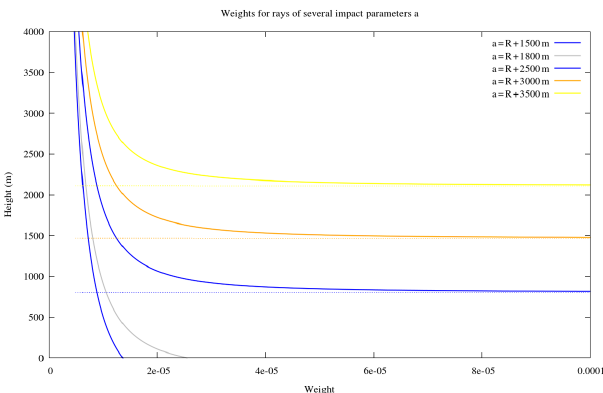
Figure 11. Kernel weight (adimensional) dependence of several paths, with respect to the local refractivity properties of the profile. Weights for three direct paths are shown, with impact parameters ( a = R + 2500m, R + 3000m, R + 3500m). These kernels present an asymptote (shown dotted, an integrable singularity), and are zero below the asymptote. Given the concentrated weight near the respective asymptote, the information provided by each observa- tion is very independent from each other, leading to an ensemble that provides information of high vertical resolution. Weights for two reflected paths are also shown, with smaller impact parameters ( a = R + 1500m, R + 1800m). These do not show any narrow con- centration of weight. They provide information that is different be- tween them, but much less independent vertically. With the refrac- tivity profile used, the apparent horizon was approximately located at a S = R +